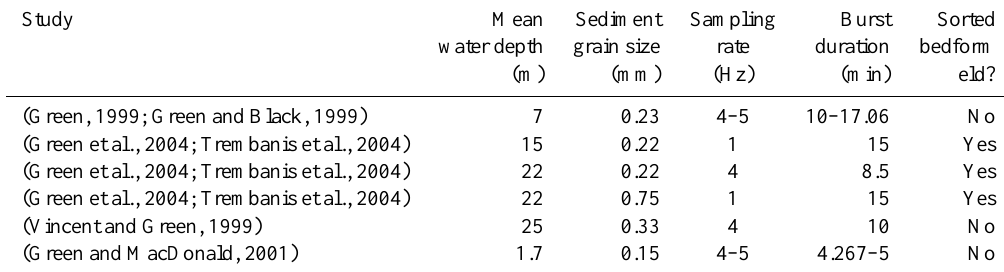
Table 1. Summary of experiments used in this study. Study Mean Sediment Sampling Burst Sorted water depth grain size rate duration bedform (m) (mm) (Hz) (min) field? (Green, 1999; Green and Black,